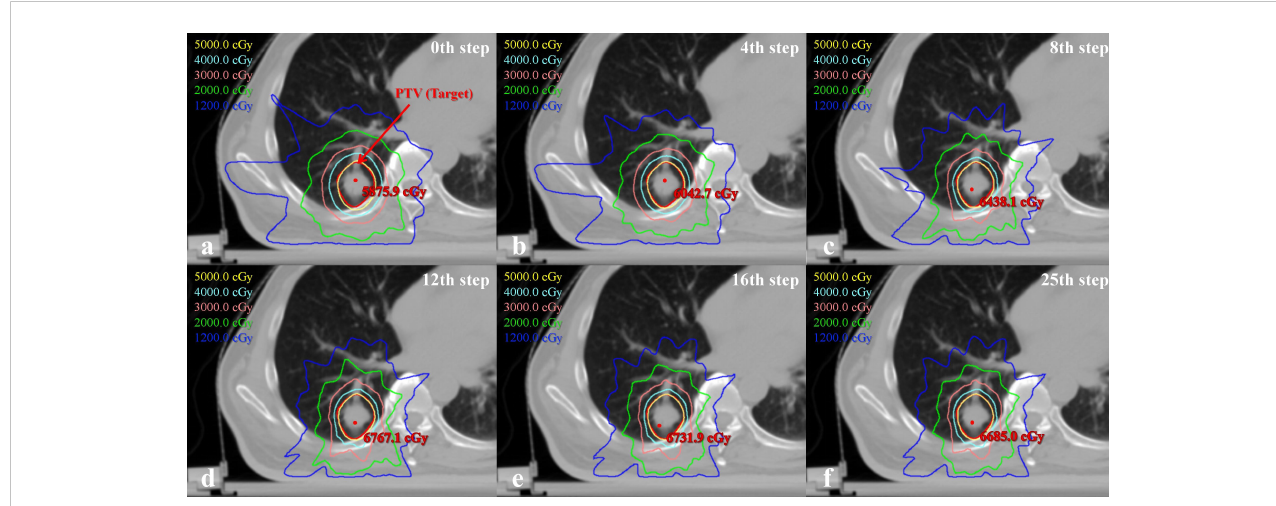
FIGURE 8 Comparison of the transverse isodose distributions between 0th, 4th, 8th, 12th, 16th and 25th adjustment steps for one representative case.